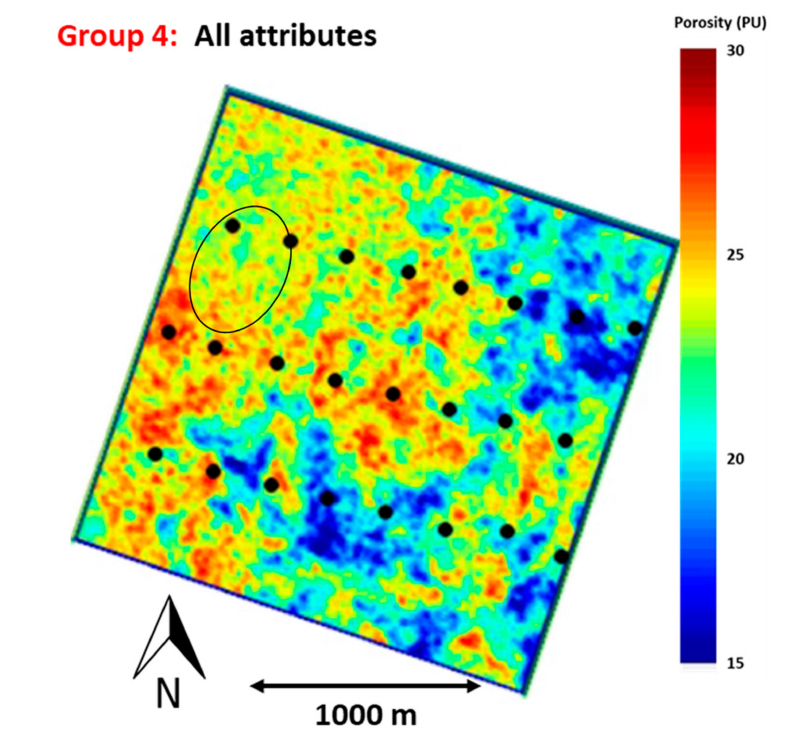
Figure 12. Map of average porosity over a 20-ms window below the main reservoir top. The map was obtained by slicing the porosity volume from Group 4. Black dots are well locations. The black circle highlights an example of what could be channel-like features in a fan-delta environment.